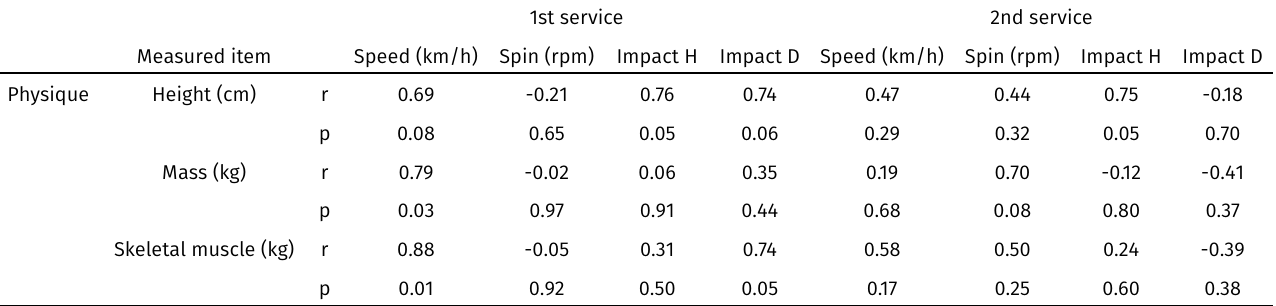
Table 2-2. The partial correlation coefficient of physique and physical strength versus service performance in female players. 1st service 2nd service Measured